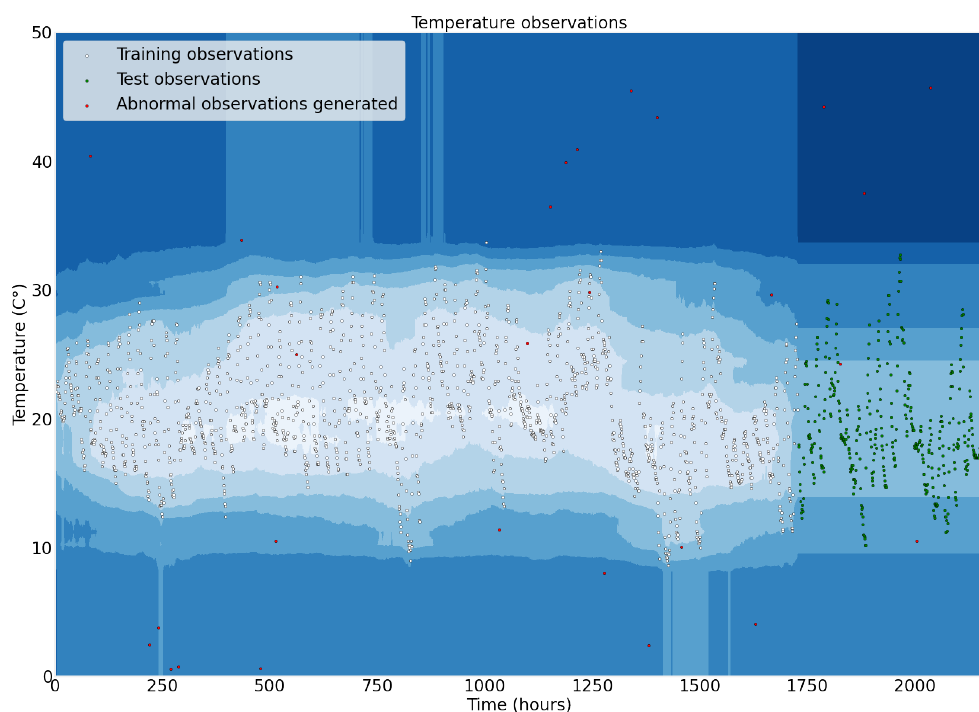
Figure 29. Temperature observations used to train and test the Isolation Forest model.